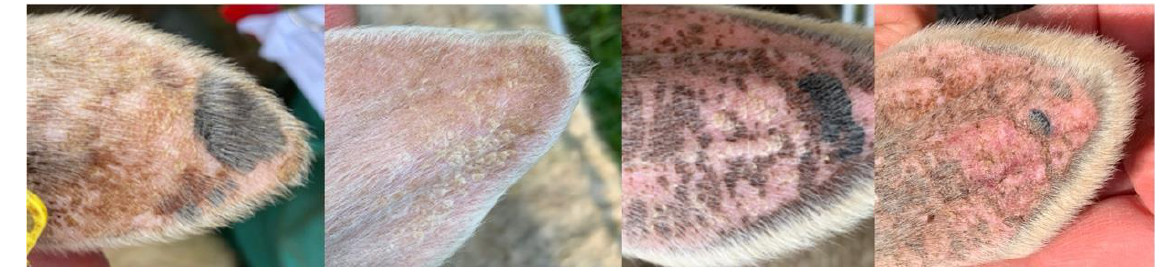
Figure 1. Small distortions of sunburn, pigment changes, crusts, and blisters at the ears.